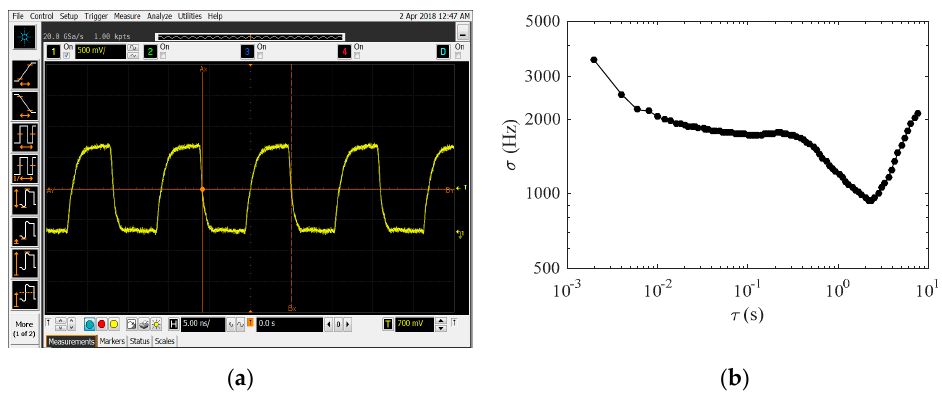
Figure 11. ( a ) Mixer output waveform, ( b ) Allan’s deviation at counter output.